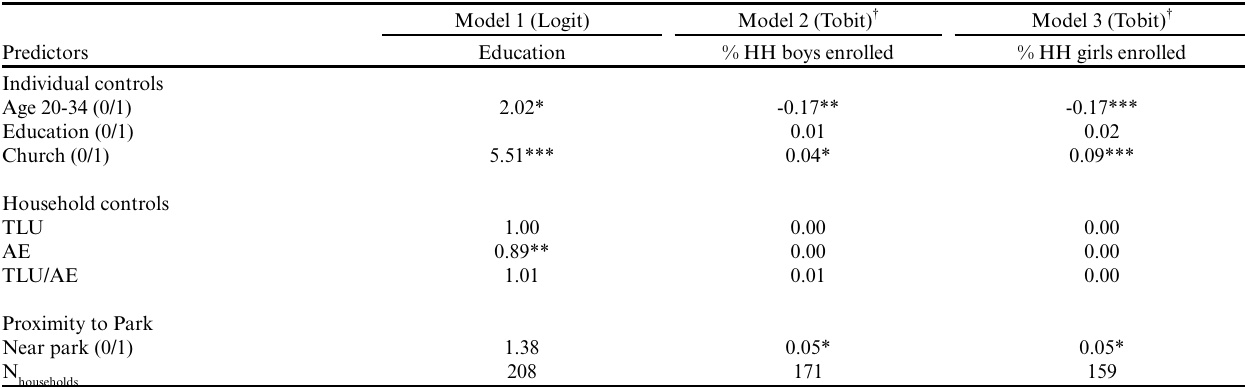
Table 3 . Variable coefficients and significance tests from logistic and Tobit models of household education